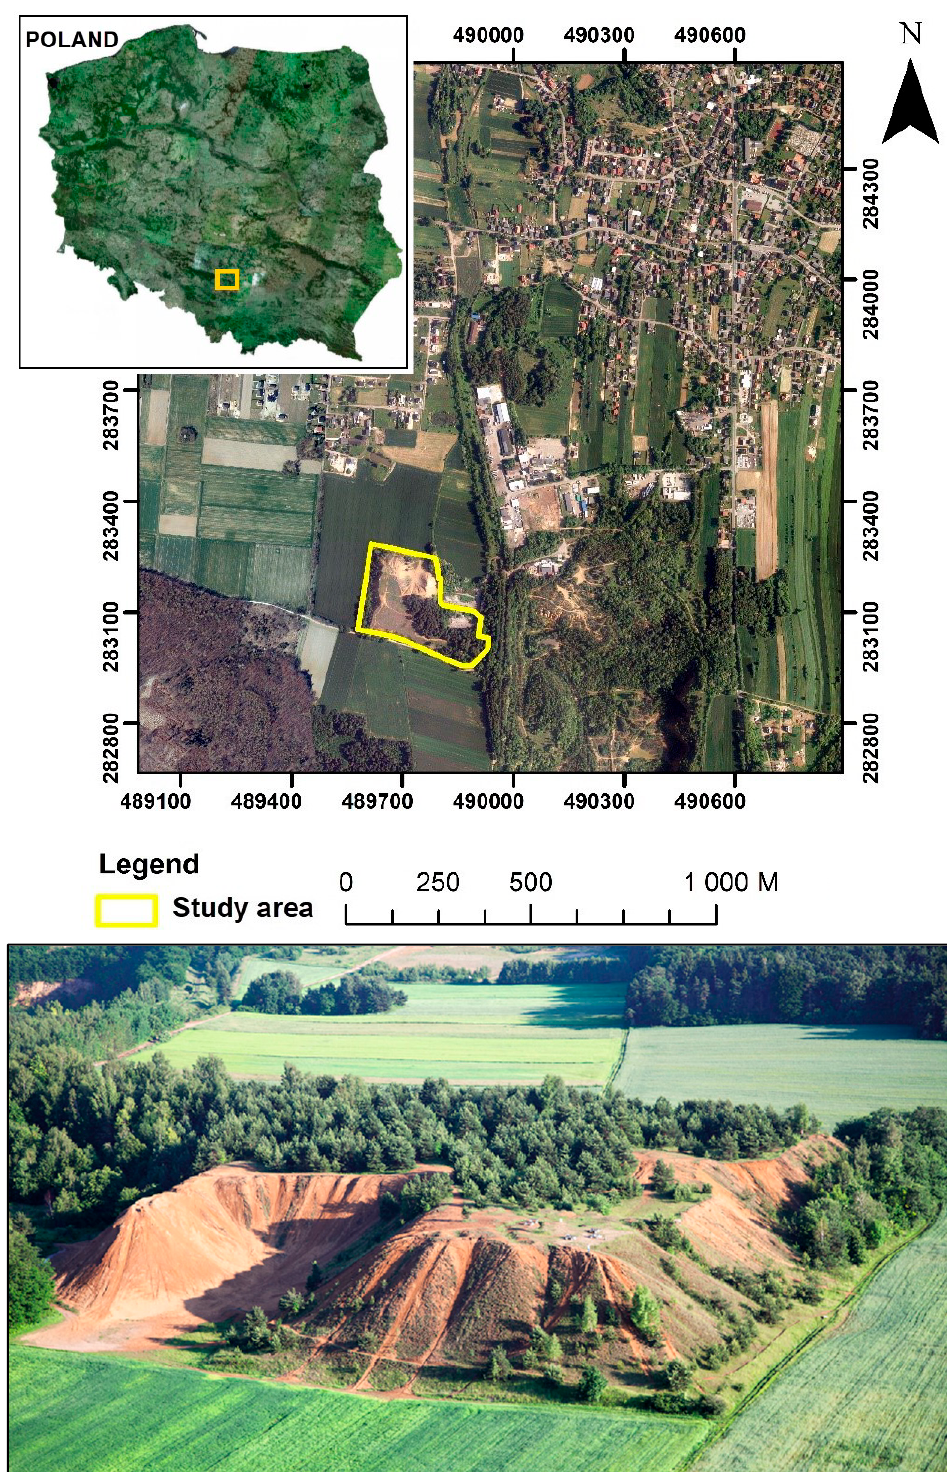
Figure 1. The analyzed area (marked yellow): orthophotomap (year: 2019, coordinates system: PL-PUWG1992) and an aerial view [7].